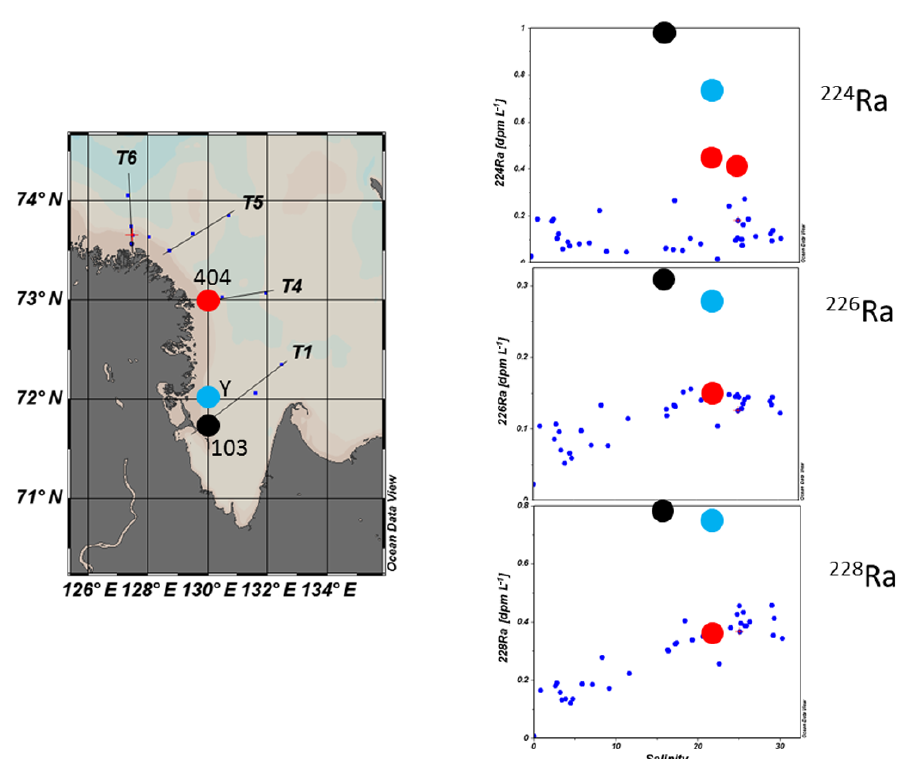
Figure 10. Activities of 224 Ra, 226 Ra, and 228 Ra as function of salinity during the summertime cruise. Bottom water activities at station 103 (12m, black) and Y (10m, blue) are the only ones that stand out for all three isotopes. Figure made with Ocean Data View (R. Schlitzer, Ocean Data View, http://odv.awi.de,